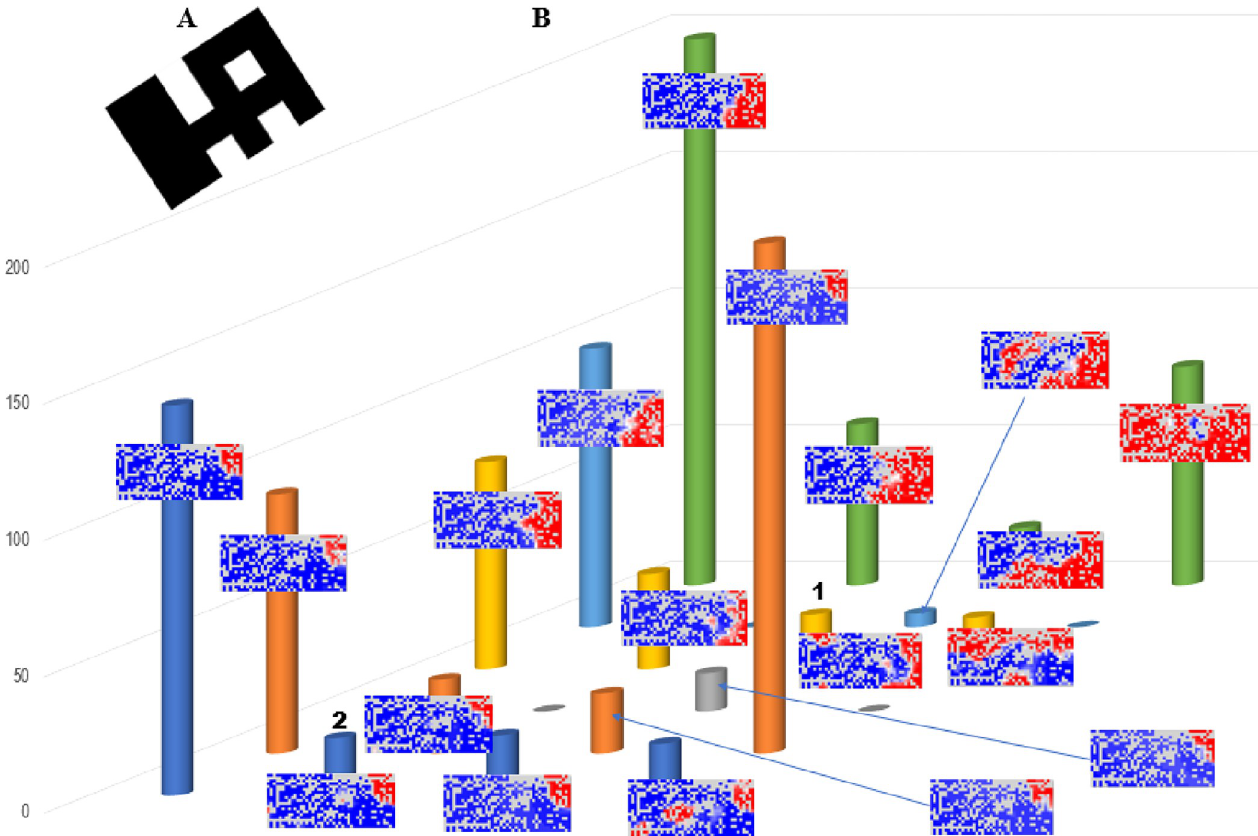
Fig 3. BLSOM for heatmap patterns. (A) BLSOM of 1169 heatmaps from the BLSOM presented in Fig 2A. Nodes including more than one heatmap are indicated in black, and those that include no patterns were left in blank (white). The 2D patten is deliberately tilted to show the relationship with the following 3D display in an easy-to-understand manner. (B) 3D display of the BLSOM presented in A. The number of patterns belonging to each node is indicated by the height of the colored column, and for each column, a representative example of heatmaps attributed to the corresponding node is shown.